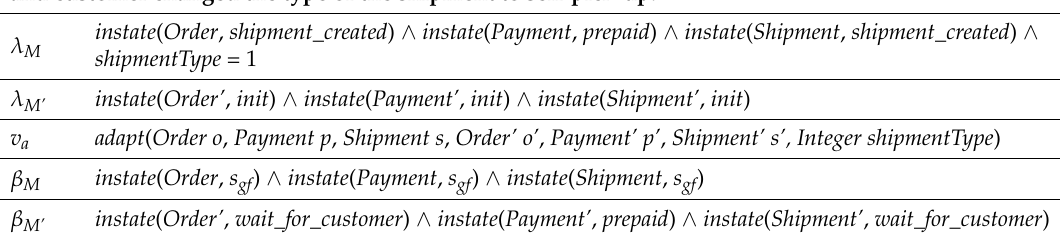
Table 3. The adaptation rule r a that is used for the